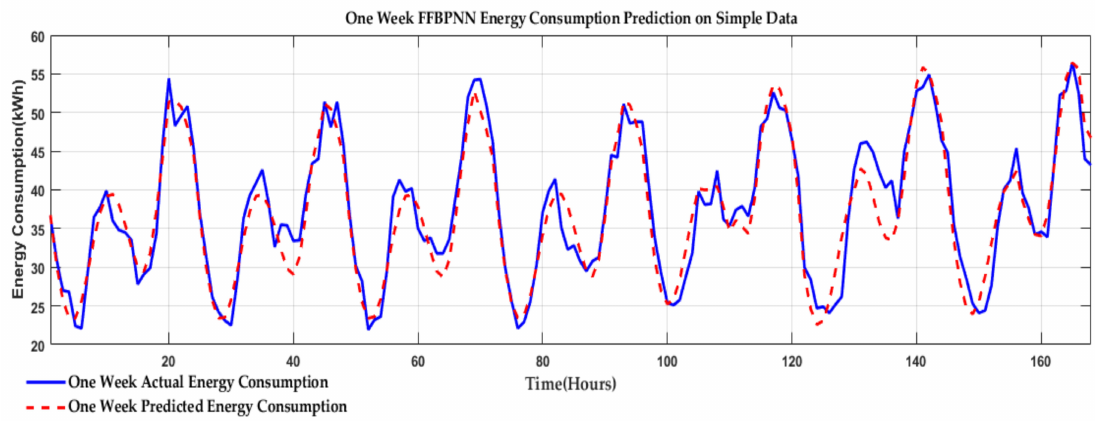
Figure 12. One week hourly energy consumption prediction using FFBPNN on simple data. Table 1 present the statistical summary of the results of the FFBPNN for one day (1D), two days (2D), five days (5D), and one week (W) hourly energy consumption prediction on simple data. The values of these statistical measures are high which indicate that the FFBPNN performance on data with no preprocessing is not impressive. In order to improve the performance, some tweaks are required to be added into data. Table 1. Statistical measures result in ANN on simple data (SD). Statistical Measures MAE MAPE RMSE ANN on SD (1D) 1.6609